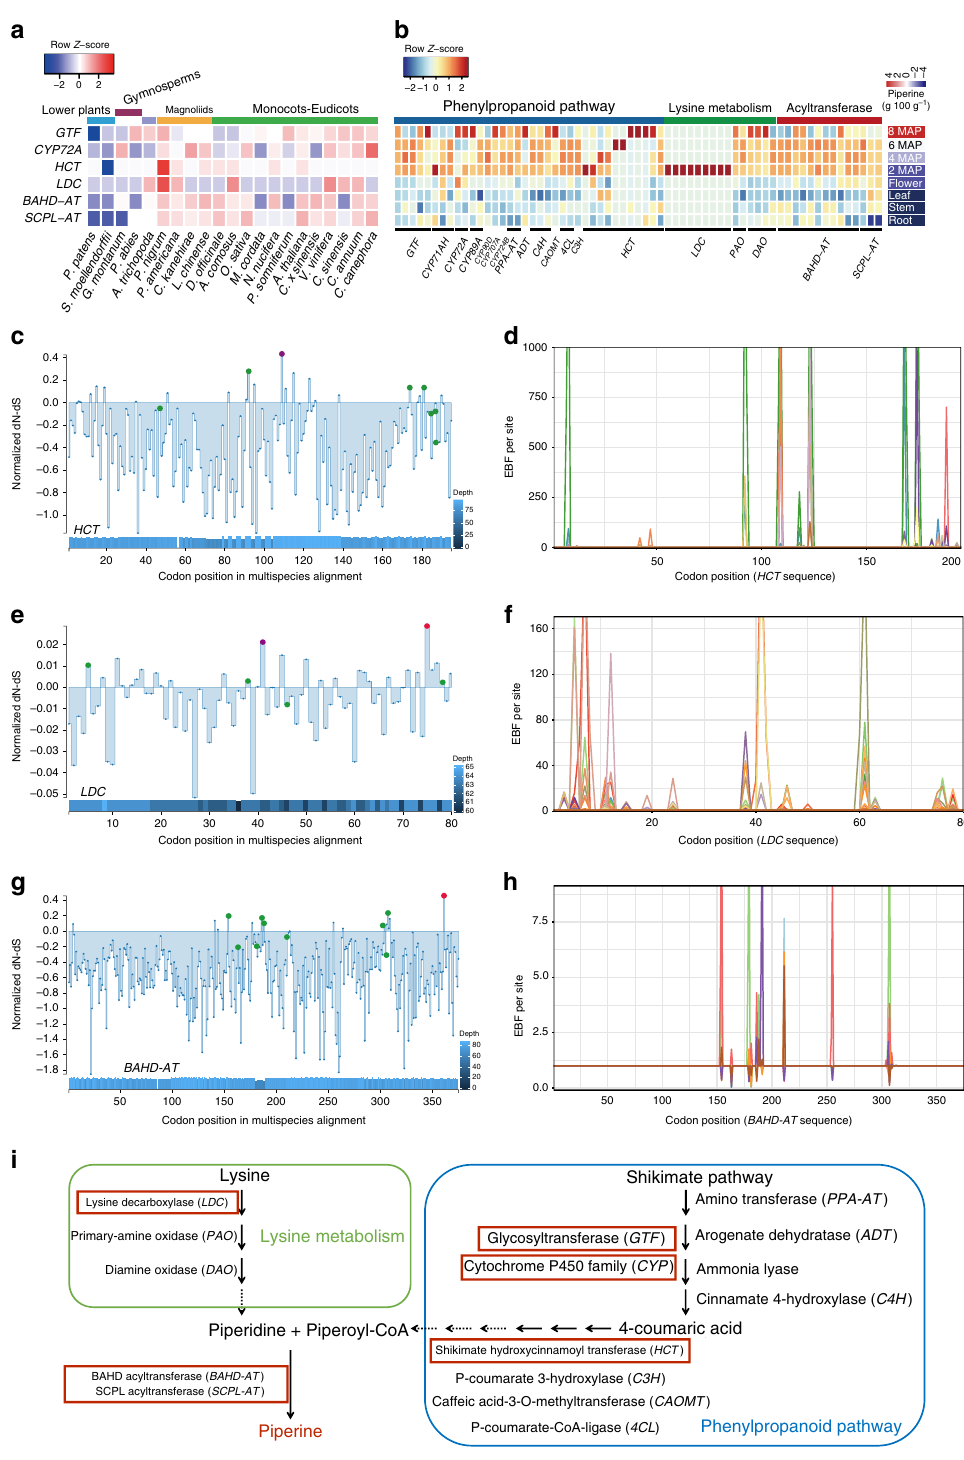
tryptophan biosynthesis (map00400). The other category was pathogen infection and animal ingestion are a source of major disease resistance-related genes, such as disease-resistance selection pressure on black pepper in the tropical rainforest. proteins (RPS5, RPP13, RGA1, RGA2, RGA3, RGA4 and RGA5), NBS-LRR disease-resistance proteins, LRR receptor- Upregulation of piperine biosynthesis-related genes . The like serine/threonine protein kinases (EFR, BAM1, FLS2, GSO2 and EMS1) (Supplementary Fig. 34 g, h) and salicylic acid- piperine content determined using high-performance liquid binding protein 2. These genes have been widely reported to chromatography (HPLC) (Supplementary Note 5) revealed that play important roles in pathogen-resistance mechanisms. The the organ with the highest content was berry at 8 months after expansion of these genes might indicate that biotic stresses from pollination (MAP), followed by 6 MAP, 4 MAP, 2 MAP, fl ower, NATURE COMMUNICATIONS| (2019) 10:4702